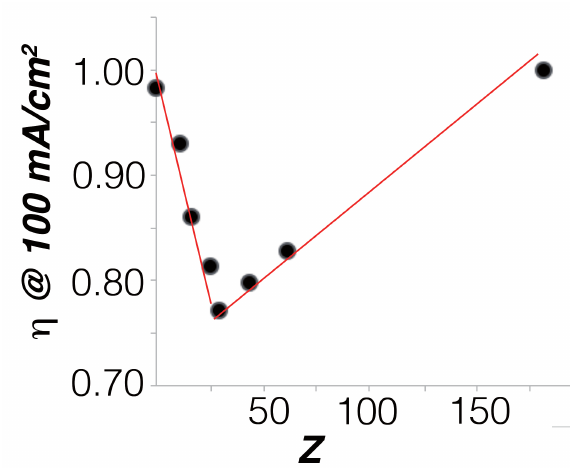
Figure 2. Plot of the overpotential ( η ) needed to reach a current density of 100 mA/cm 2 in the series of